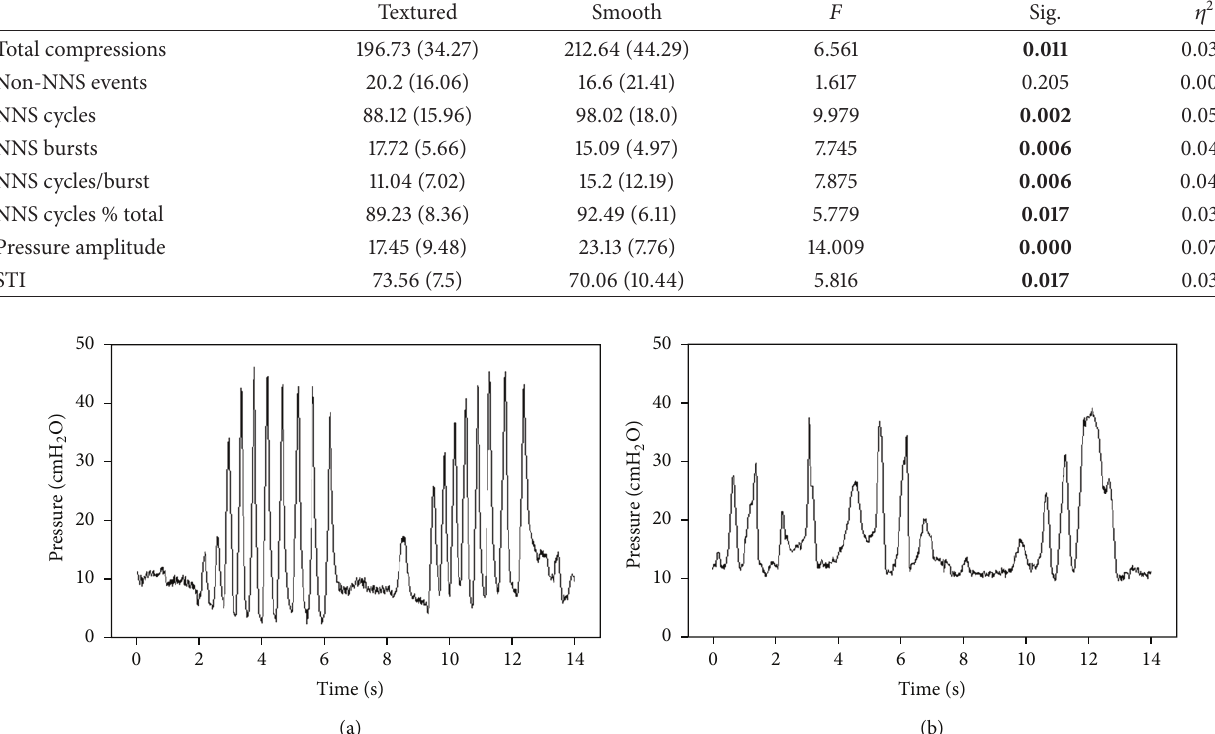
Figure 2: (a) Characteristic burst-pause pattern of NNS of an infant. (b) Oral compression pattern of the same infant when given the 1mm textured Barrel array